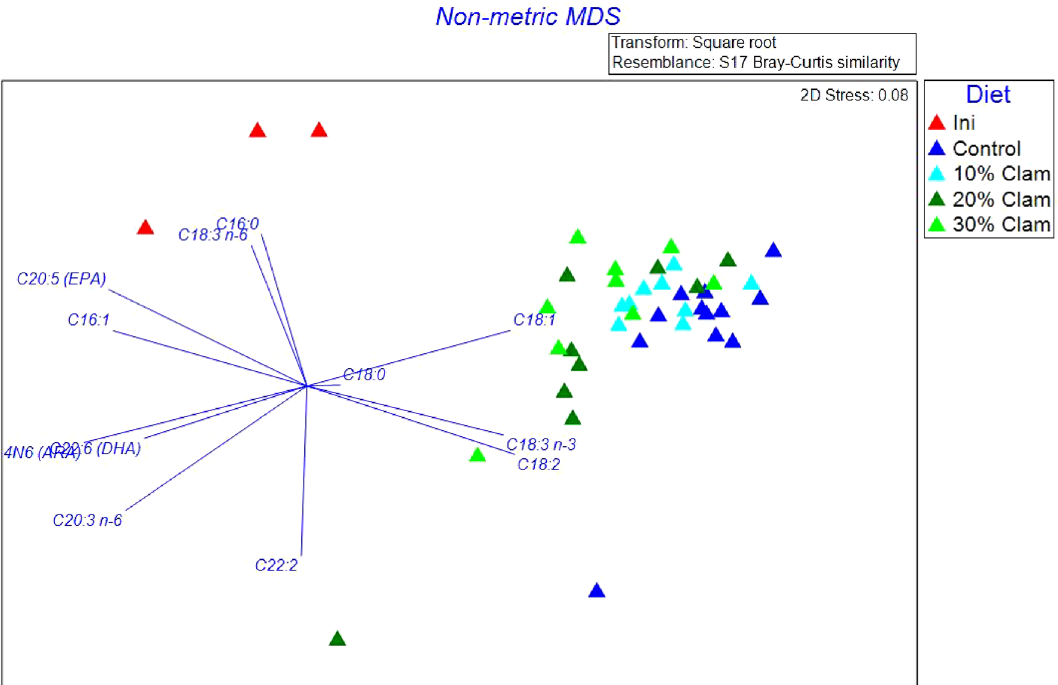
Figure 4. Non-metric multidimensional scaling (n-MDS) of the Bray–Curtis similarity matrix based on the relative abundance of fatty acid profiles associated with Florida pompano ( Trachinotus carolinus ) juveniles at the start of the experiment (red triangles; Initial); juveniles fed a control diet (dark blue triangles); juveniles fed a 10% clam meal (CM) substitution diet (light blue triangles); juveniles fed a 20% CM substitution diet (dark green triangles); and juveniles fed a 30% CM substitution diet (light green triangles). The n-MDS shows two main clusters: 1st cluster regroups all juvenile samples issued from all four diets; and the second cluster (red triangles) regroups initial juvenile samples before the onset of the feed experiment. The arrows length and direction represent the fatty acids responsible for most of the variation.